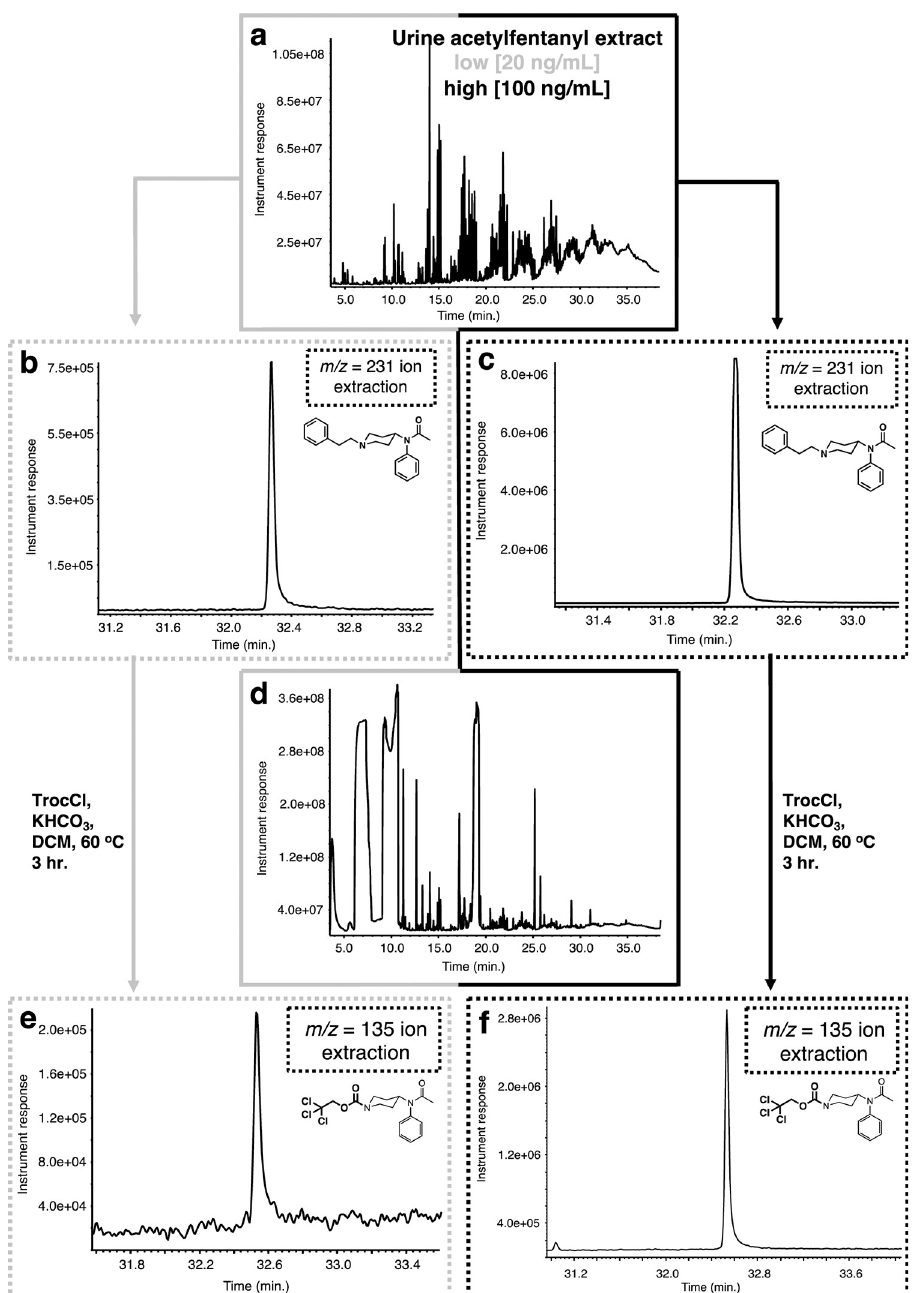
Fig 9. Extraction and reaction of acetylfentanyl with Troc-Cl when spiked in urine. (a) GC chromatogram of extracted urine sample; (b) extracted ion (m/z = 231) chromatogram for acetylfentanyl (rt = 32.3 min.) for low concentration urine spike (20 ng/mL); (c) extracted ion (m/z = 231) chromatogram for fentanyl for high concentration urine spike (100 ng/mL); (d) GC chromatogram of the reaction between extracted urine sample and Troc-Cl; (e) extracted ion (m/z = 135) chromatogram for Troc-norfentanyl for the low concentration urine sample (rt = 32.6 min.); (f) extracted ion (m/z = 135) chromatogram for Troc-norfentanyl for the high concentration spiked urine sample.